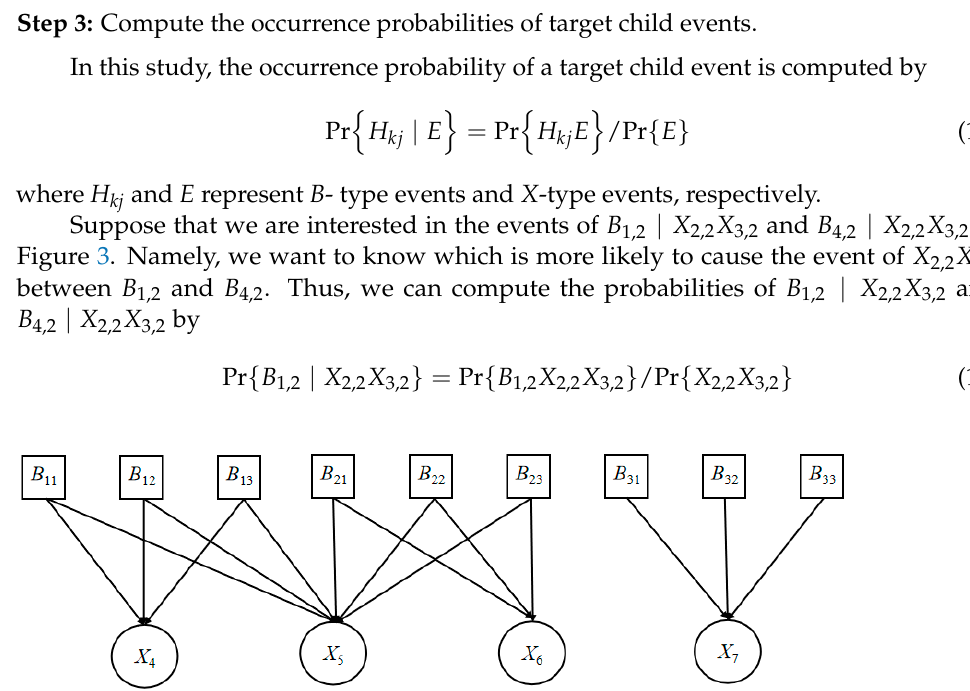
Figure 3. The PUL ‐ DUCG for root cause analysis of an abnormal superheat degree. Figure 3. The PUL-DUCG for root cause analysis of an abnormal superheat